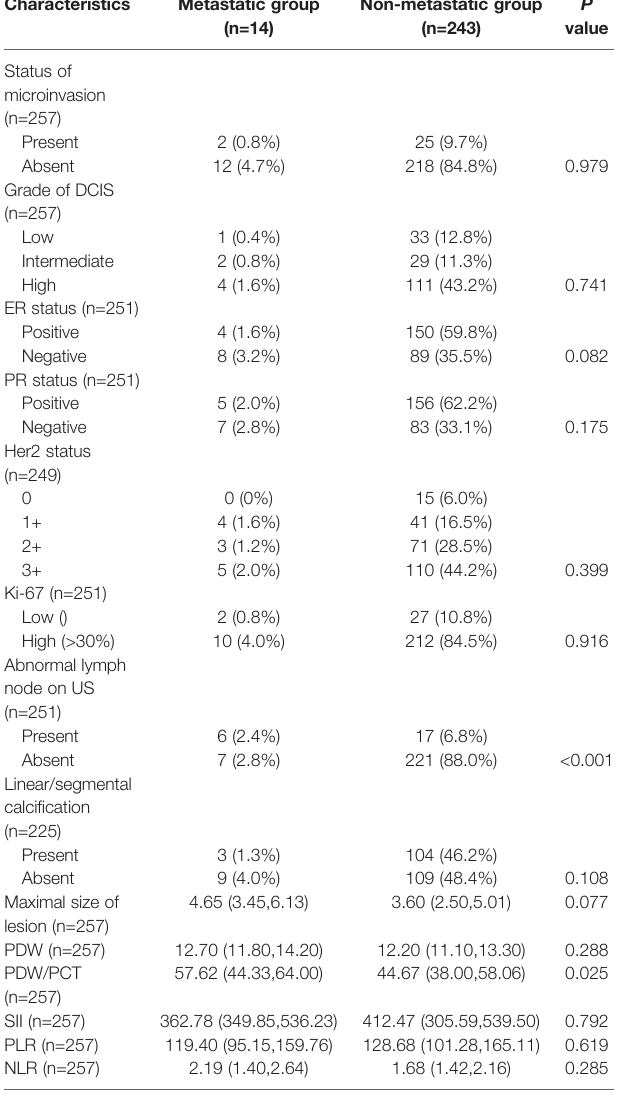
TABLE 3 | Characteristics between metastatic and non-metastatic groups. Characteristics